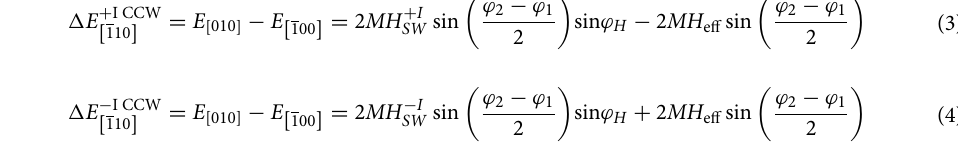
110 barrier. ± I (cid:31) (cid:30) SW and sin φ H in the form